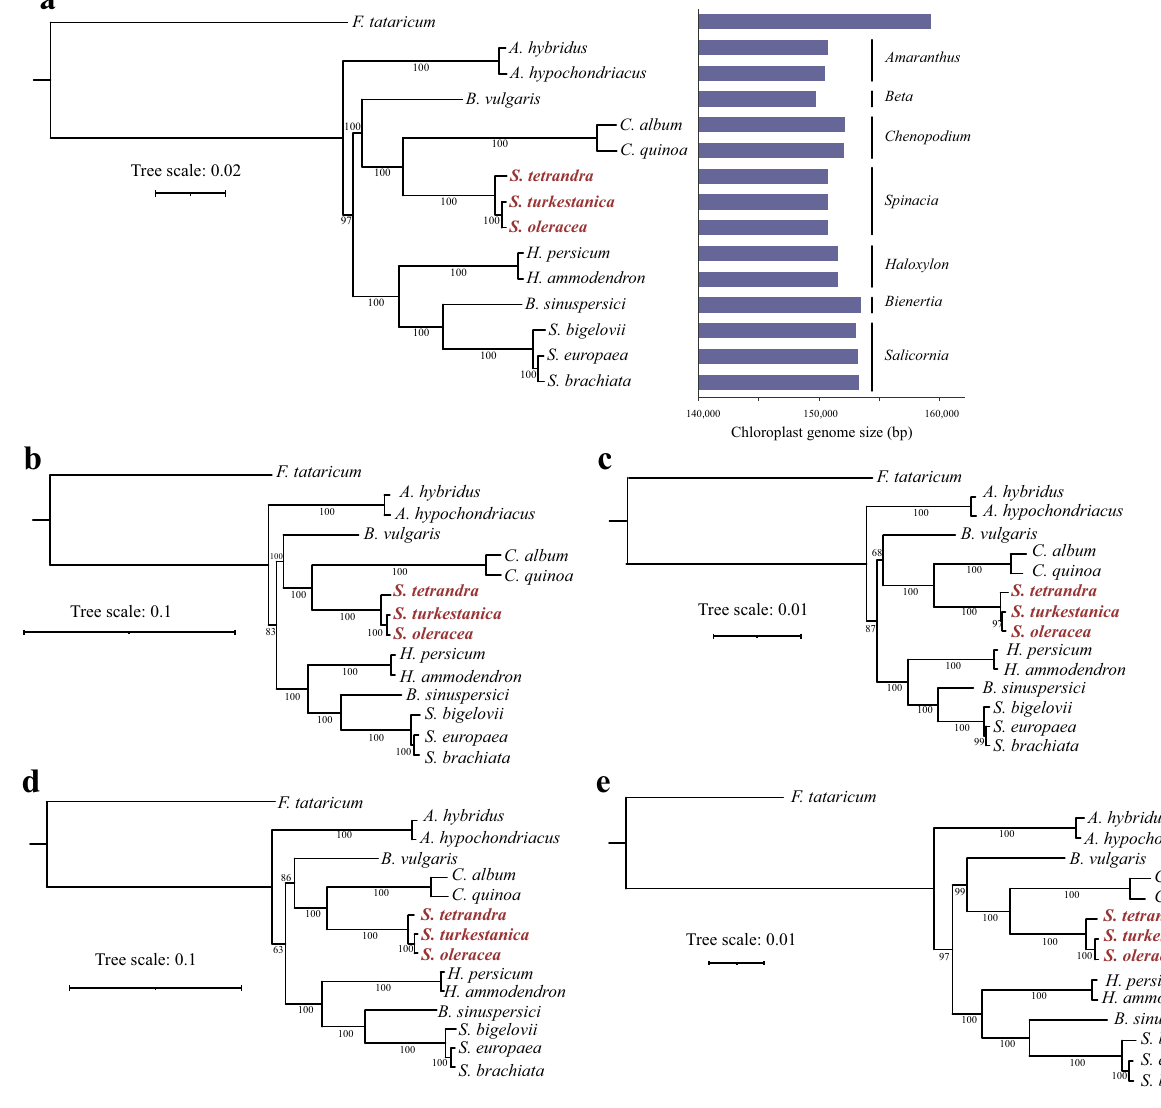
Figure 2. Phylogenetic trees of the 14 Amaranthaceae plants based on chloroplast genomes and the variation in their chloroplast genome size. The phylogenetic tree was constructed using the ( a ) complete chloroplast genome data, ( b ) LSC region, (c) IR region, ( d ) SSC region, and ( e ) protein sequences, with F. tataricum as an outgroup. Numbers near branches are bootstrap